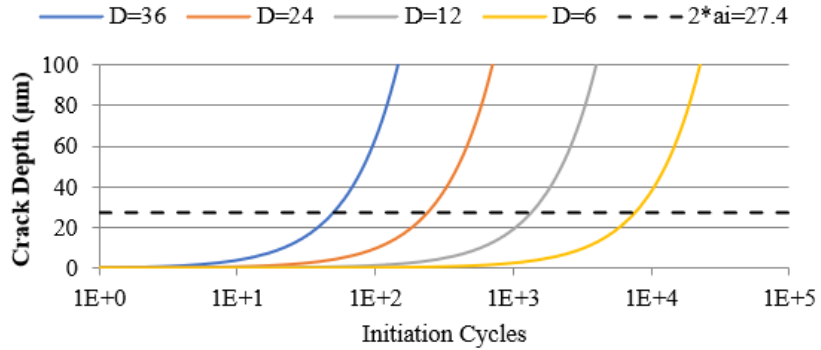
Figure 5. Microstructure of Ti-6Al-4V with 60% primary α grain ( light phase ) and 40% of α + β Widmanstatten colonies ( dark phase ) [31].